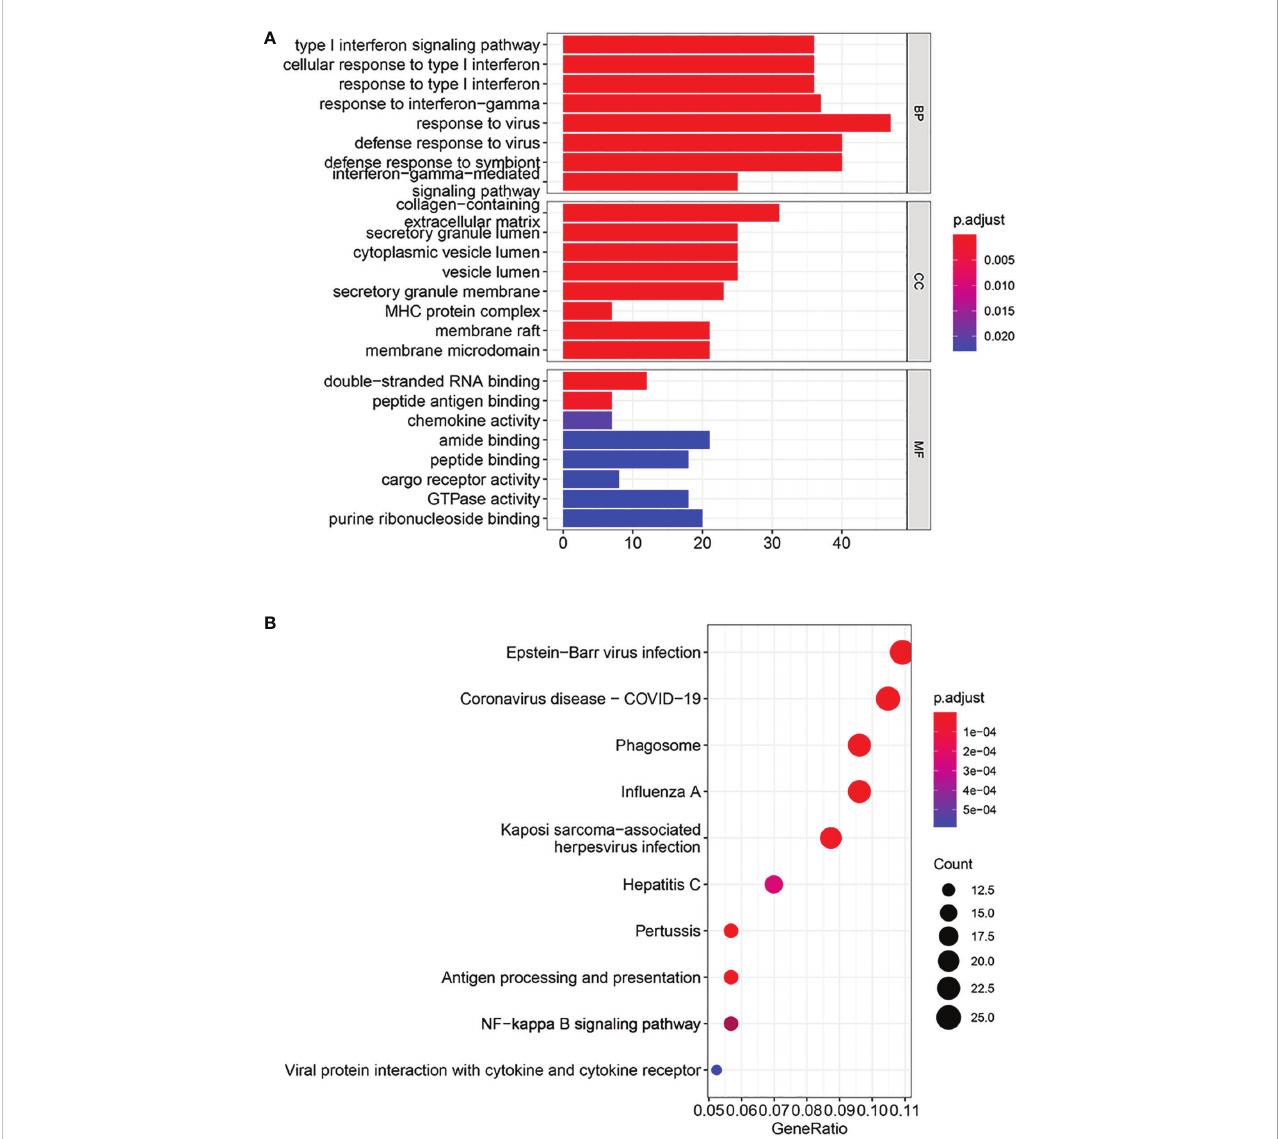
FIGURE 3 Analyses of functional enrichment. (A) GO enrichment analysis by DEGs. (B) KEGG pathways enriched by